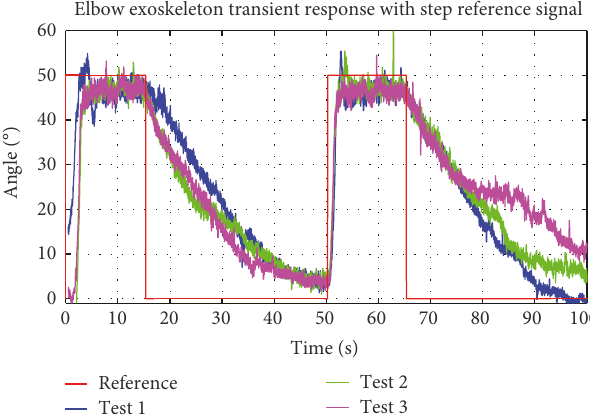
Figure 15: Elbow exoskeleton time response in experimental tests with step